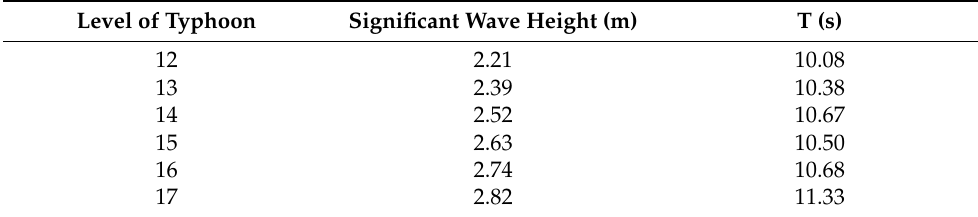
Table 1. Wave boundary conditions for the BW model.